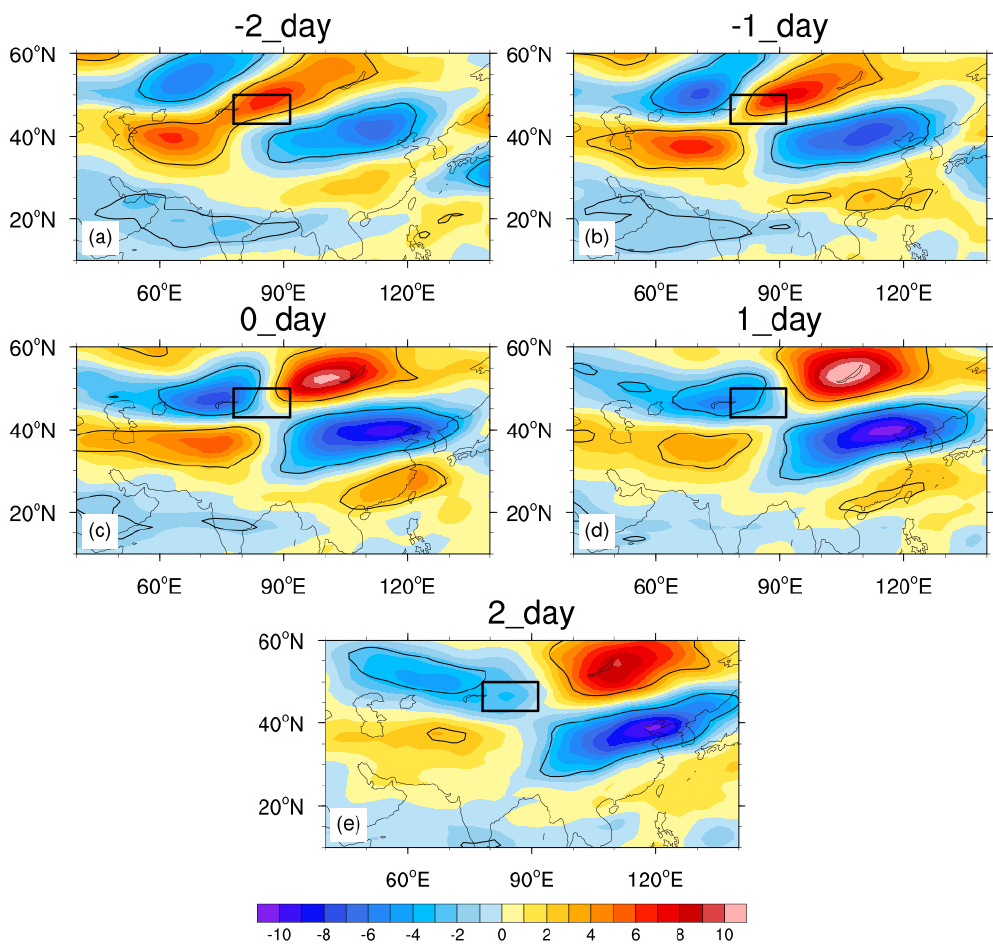
Figure 11. Composition of U200 anomaly of Type CT on the extreme precipitation day and the two days before and after ( a – e ) in the summers of 1979–2018 (Unit: m/s). The black box represents the location of the Northern Xinjiang region, and the region over the 95% significant confidence level is circled with black lines.